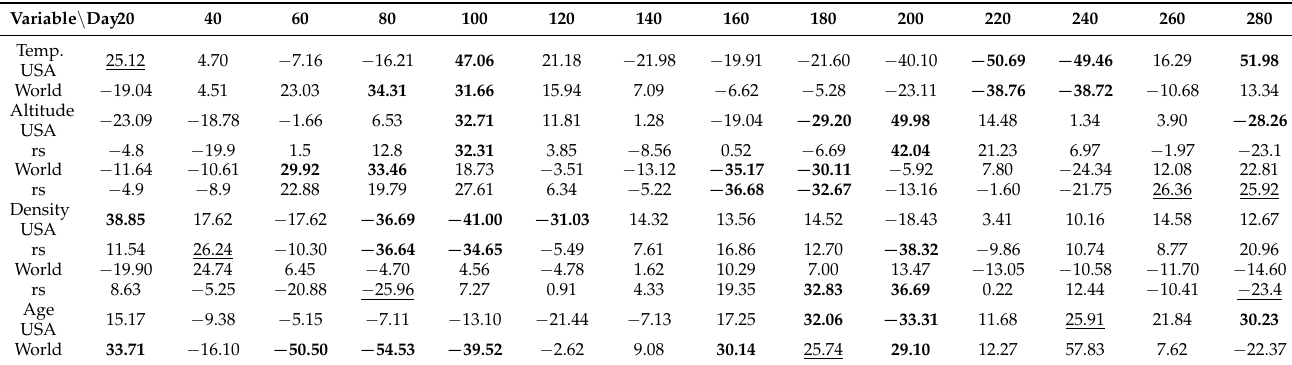
Table 6. Pearson correlation coefficients r ( × 100) between spread rates for consecutive nonoverlapping 20-day periods from Tables 3 and 4 with environmental variables from Tables 2 and 6. Rows starting with USA give r between spread rates and environmental factors for the US states, rows starting with world are for countries. Rows starting with rs present nonparametric Spearman rank correlation coefficients rs for the two variables, altitude and density, that differ at p < 0.05 from normality according to Kolmogorov–Sminov tests. Bold, underlined indicate that correlations are statistically significant at p < 0.05 according to a two- and one-tailed test, respectively.